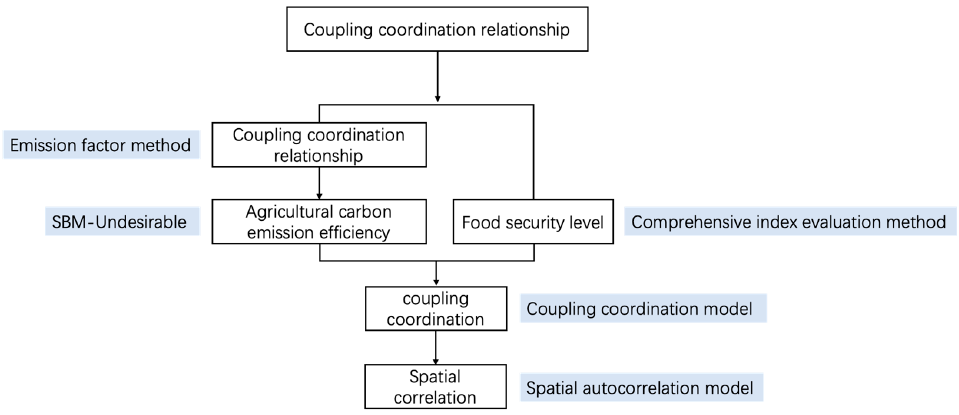
Figure 1. Methodology steps diagram.